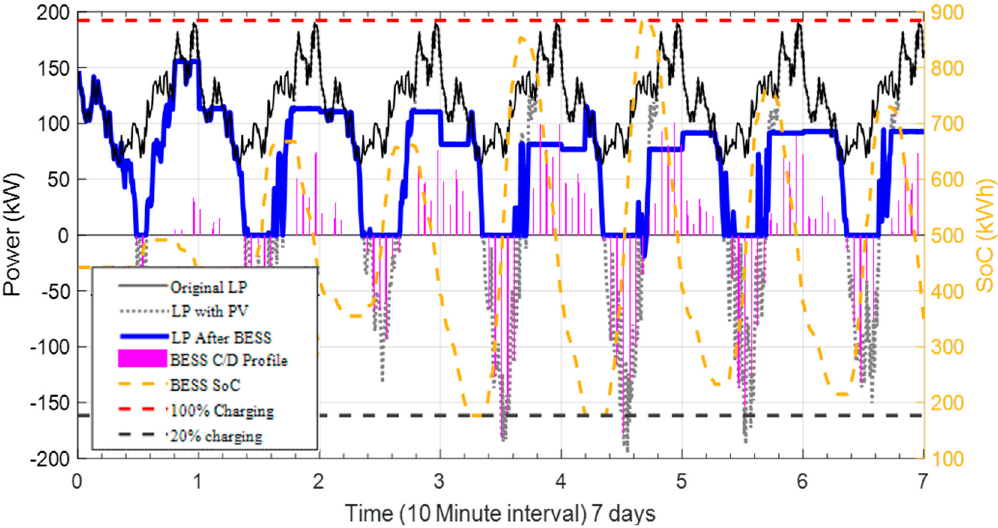
Figure 11. Seven ‐ day load profiles for 50% PV penetration with PV and BESS for PVGS (1–7 January 2016).